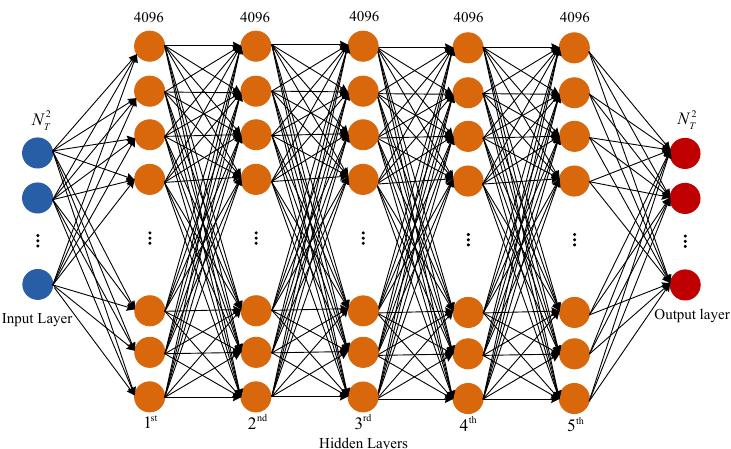
Figure 5. Architecture of